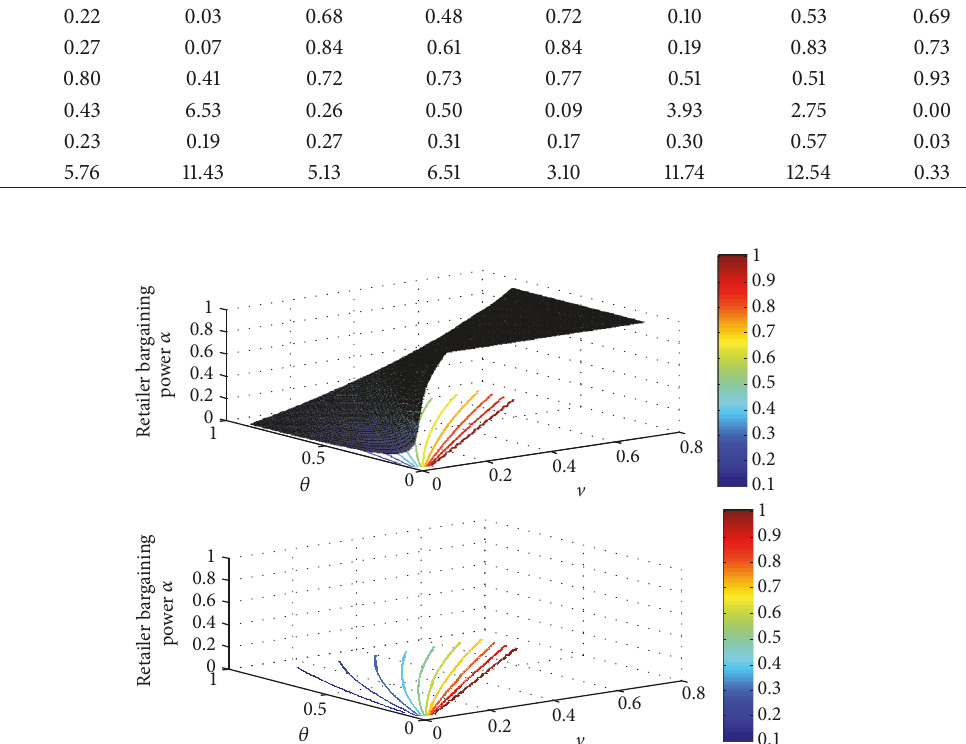
Figure 3: Relationship between the retailer’s bargaining power and the technical parameters.